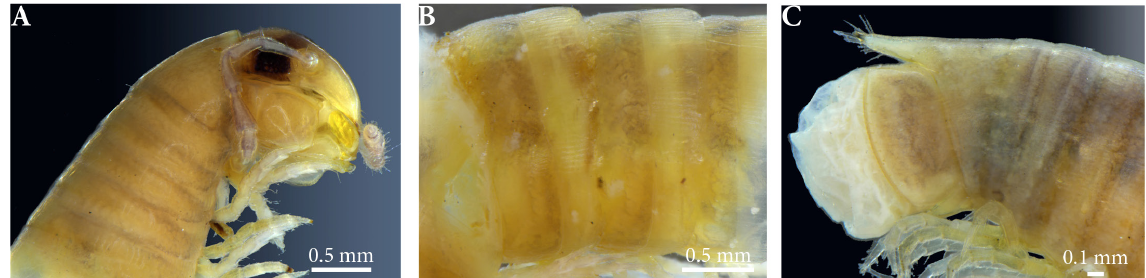
body rings. B . Mid-body rings. C . Posterior-most body